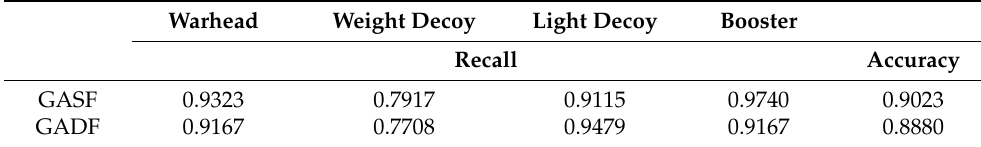
Table 4. The classification evaluation based on GAFs.